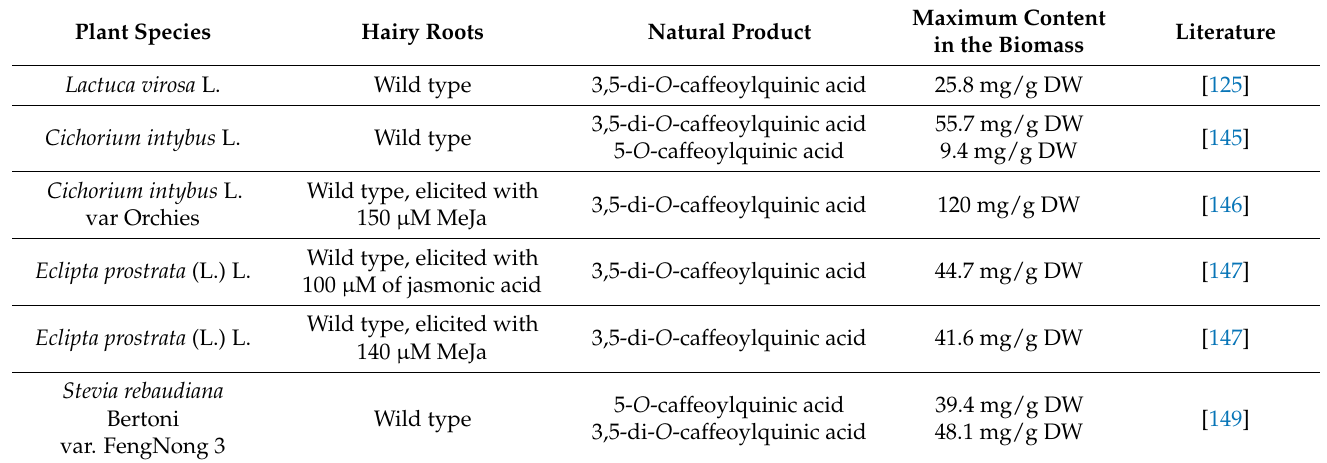
Table 4. Hairy root cultures that produced high yields of acylquinic